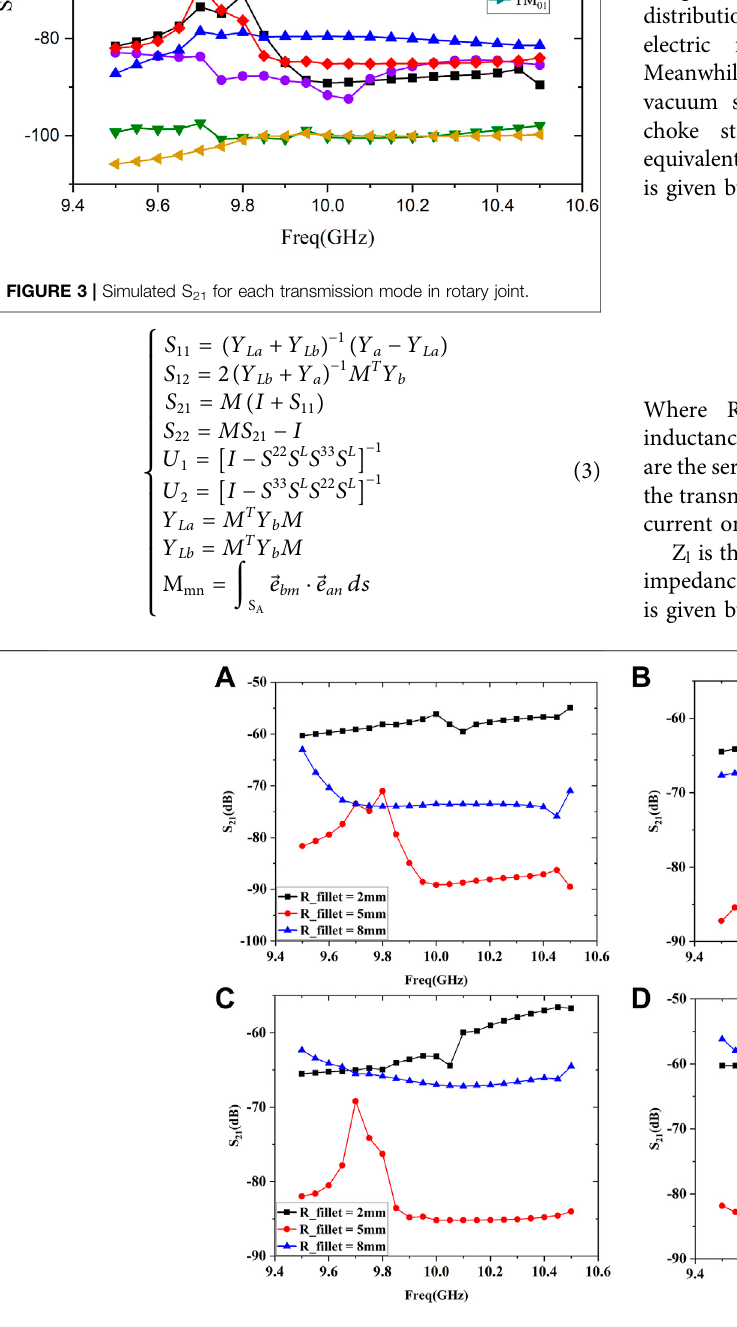
FIGURE 4 | In fl uenceofradialslot fi lletradiusoncoupledmodetransmission. (A) TE 11 mode. (B) TM 11 mode. (C) TE 31 mode. (D) SumofTE 11 , TM 11 and TE 31 mode.